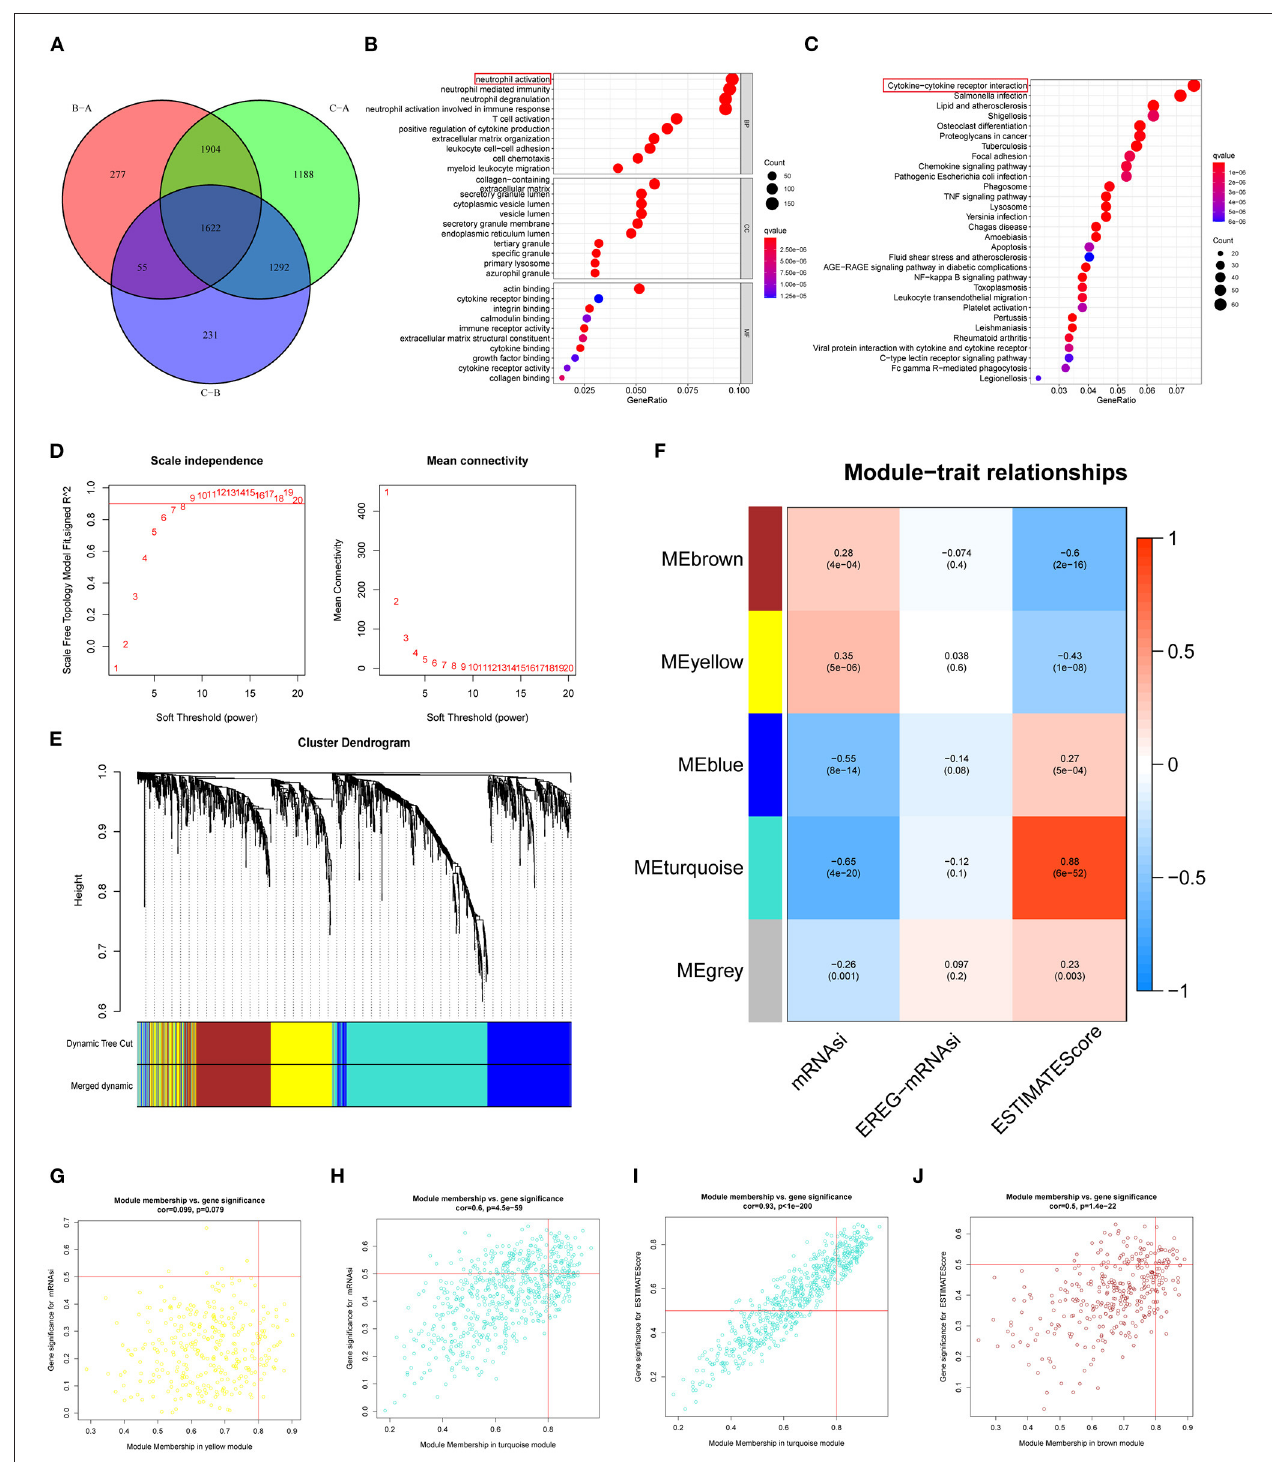
FIGURE 4 | Characteristics of potential traits in different patterns of ferroptosis regulation. (A) A Venn diagram of differential genes in three patterns ( p = 0.001). (B) GO analyses of differentially expressed. (C) KEGG pathway analyses of differentially expressed. (D–F) Hierarchical clustering dendrograms of identified coexpressed genes in modules. The branches of the cluster dendrogram correspond to the different gene modules. Each leaf corresponds to a gene. Each colored row represents a color-coded module, which contains a group of highly connected genes. A total of 5 modules were identified after the merger. (F) Correlations between the gene modules and target traits including mRNAsi, EREG-mRNAsi, and ESTIMATEScore. The corresponding p -value is increased in size from blue to red. (G–J) The four modules most significantly correlated with mRNAsi and ESTIMATEScore. Cor was the coefficient indices and p was Pearson’s correlation.